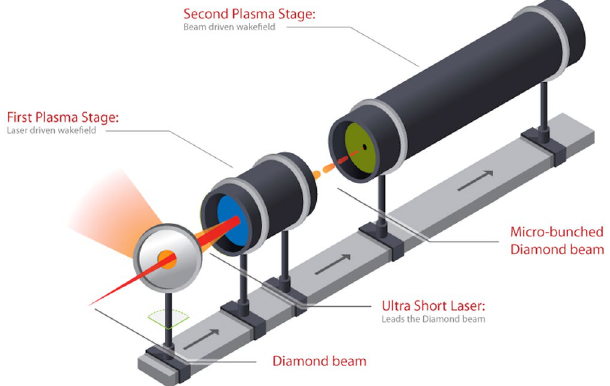
Figure 1. A conceptual design of the two stage plasma cell design. An ultra short laser pulse drives a high amplitude wakefield in the first, short stage that exposes a charged particle beam to alternating focusing and defocusing fields along its length. Micro-bunches form as the beam propagates between the two stages. Upon entering the second stage the micro-bunches resonantly drive a wakefield. This wakefield provides the focusing fields that stimulate whole micro-bunch oscillations.